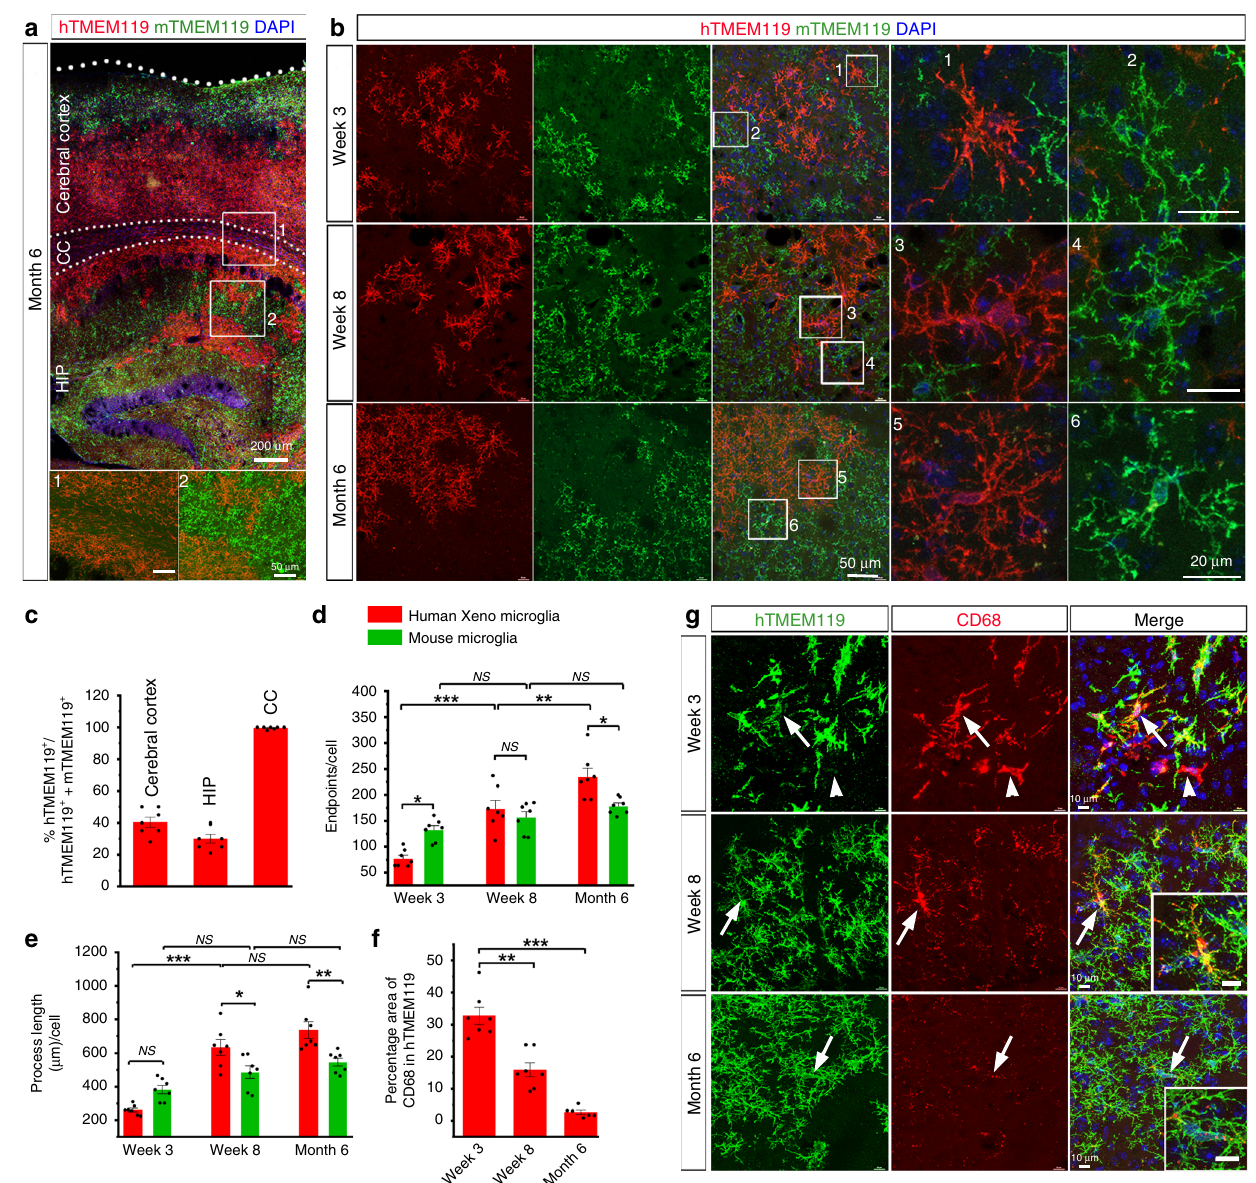
Fig. 2 Human PSC-derived microglia undergo morphological maturation. a Representatives of hTMEM119 + hPSC-derived microglia and mTMEM119 + mouse microglia in the cerebral cortex, corpus callosum (CC) and hippocampus (HIP) in 6-month-old mice. Scale bars: 200m and 50 μ m in the original and enlarged images, respectively. b Representatives of hTMEM119 + hPSC-derived microglia and mTMEM119 + mouse microglia in the cerebral cortex. Scale bars: 50 and 20 μ m in the original and enlarged images, respectively. c Quanti fi cation of the percentage of hTMEM119 + cells in total microglia (hTMEM119 + plus mTMEM119 + ) in the cerebral cortex, hippocampus (HIP), corpus callosum (CC) in 6-month-old chimeric mice ( n = 7 mice for each time point). The data are pooled from the mice received transplantation of microglia derived from both hESCs and hiPSCs. Data are presented as mean±s.e.m. d , e Quanti fi cation of endpoint numbers and total process length of mouse and hPSC-derived microglia based on mTMEM119 or hTMEM119 staining, respectively, from gray matter at the three time points ( n = 7 mice for each time point). The data are pooled from the mice received transplantation of microglia derived from both hESCs and hiPSCs. Two-way ANOVA is used to compare the endpoints and process length between human and mouse microglia and one-way ANOVA is used for the comparison within mouse or human microglia. * P <0.05, ** P <0.01, *** P <0.001, and NS no signi fi cance. Data are presented as mean±s.e.m. f Quanti fi cation of the percentage of CD68 + area in hTMEM119 + area from cerebral cortex in 3-, 8- and 6-month-old chimeric mice ( n = 7 mice for each time point). The data are pooled from the mice received transplantation of microglia derived from both hESCs and hiPSCs. One-way ANOVA test, ** P <0.01, *** P <0.001. Data are presented as mean±s.e.m. Source data are provided as a Source Data fi le. g Representatives of CD68- and hTMEM119-exprssing cells in the cerebral cortex. Scale bars: 10 or 2 μ m in the original or enlarged images,